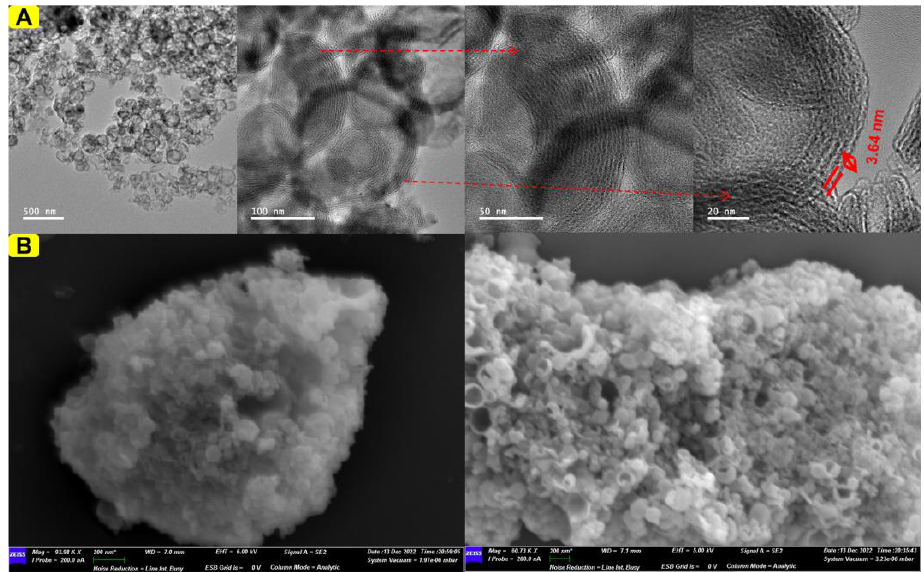
Figure 2. ( A ) UHR-TEM images of PHMS−1 ; ( B ) FE-SEM micrographs of PHMS−1 at different mag- nifications